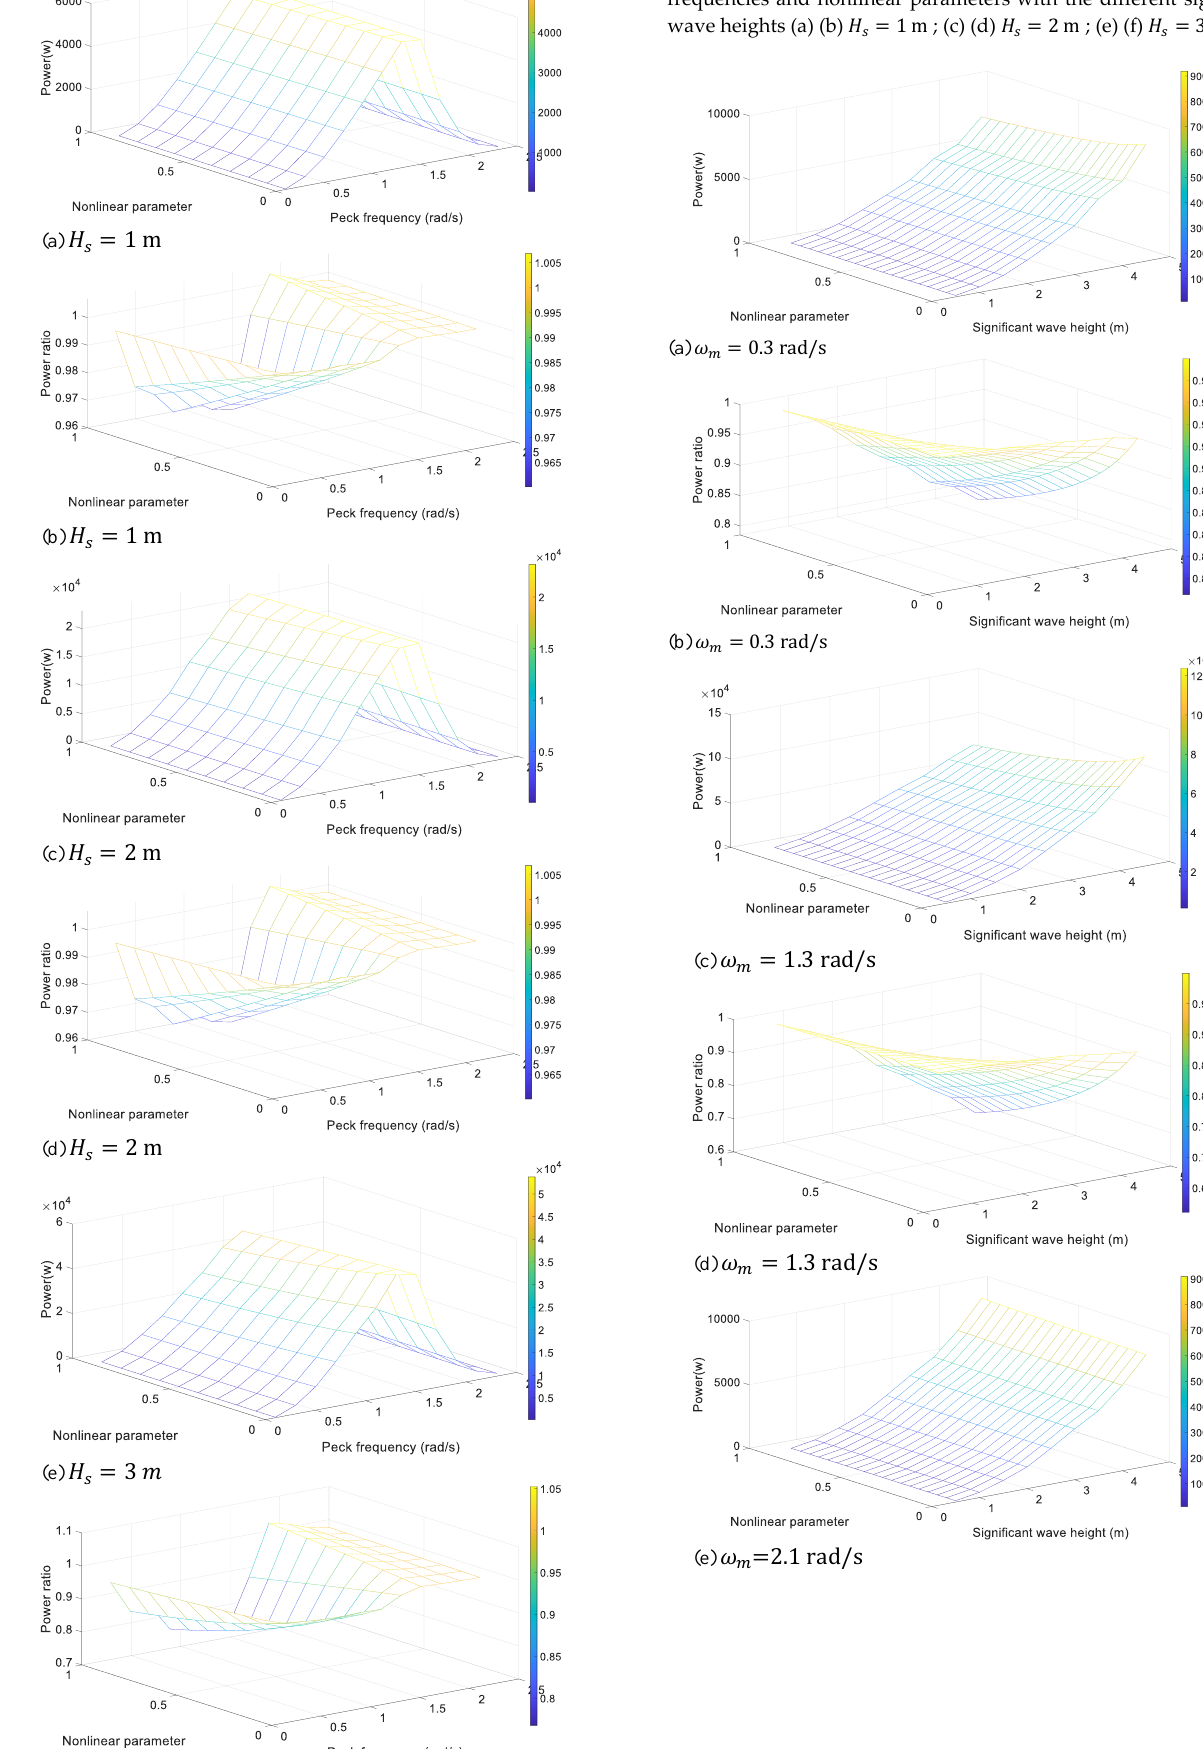
Fig. 6. The power and power ratio of WEC in different peak frequencies and nonlinear parameters with the different